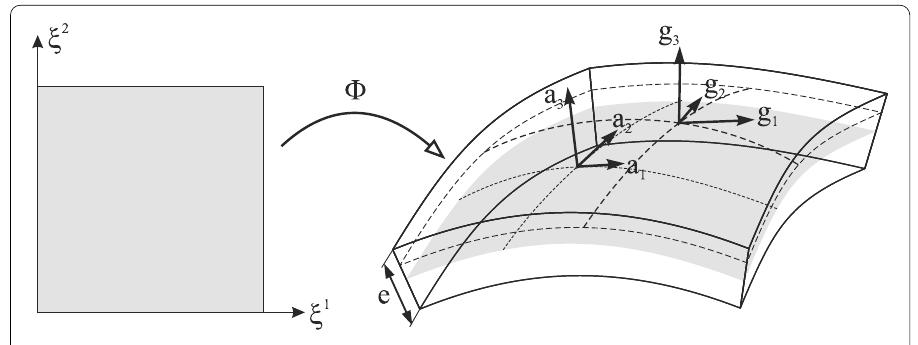
Fig. 1 The map (cid:2) (cid:6) and the local basis vectors (cid:2) a i and (cid:2) g i for a shell panel